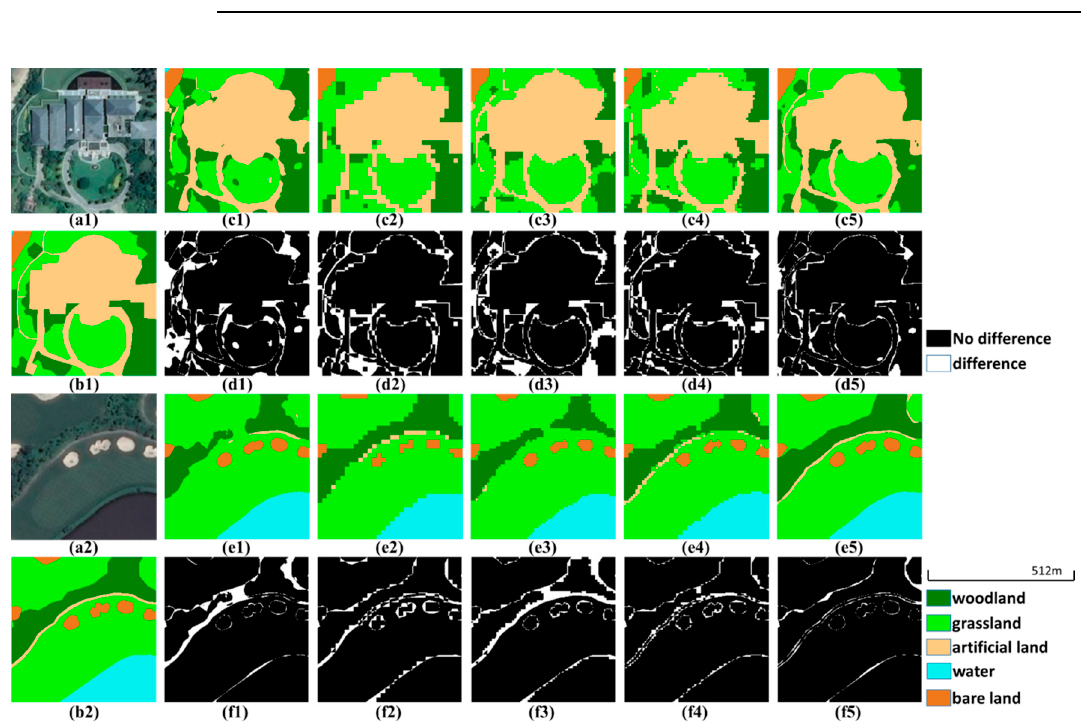
Figure 9. Prediction examples in the validation set of dataset A. ( a1 , a2 ) True color images. ( b1 , b2 ) Ground truth images.